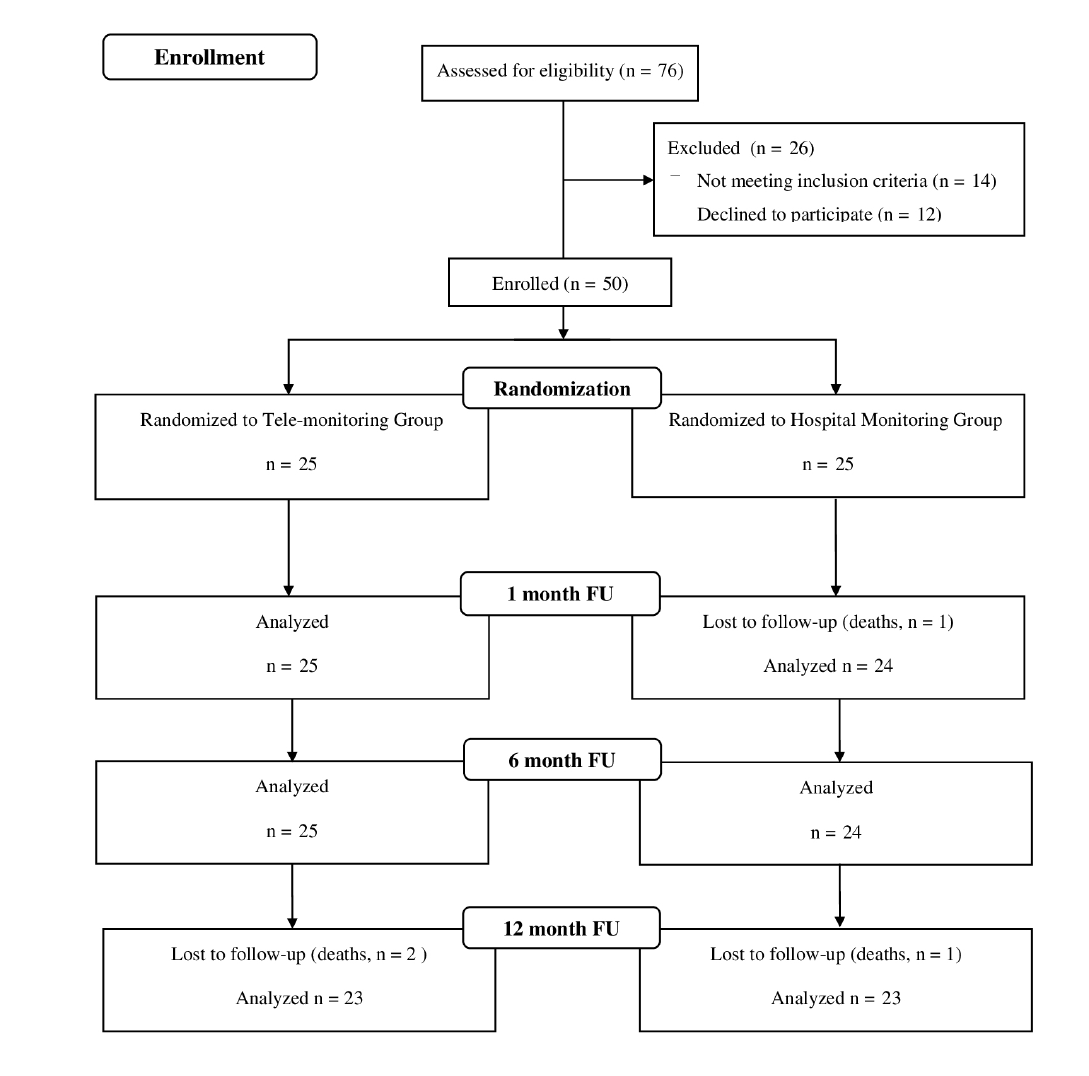
Figure 1. Flow (CONSORT) diagram of the